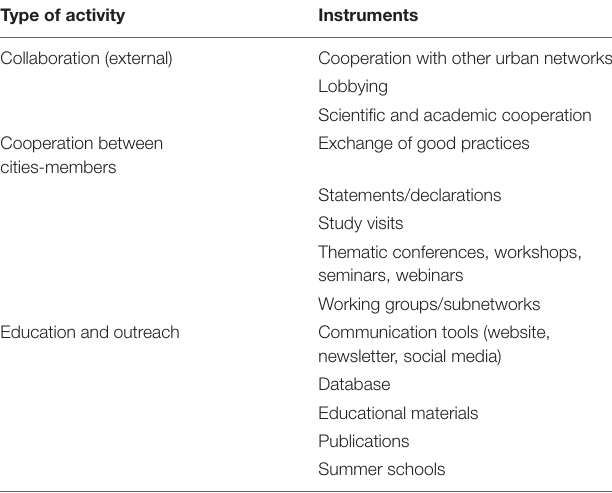
TABLE 4 | List of cooperation